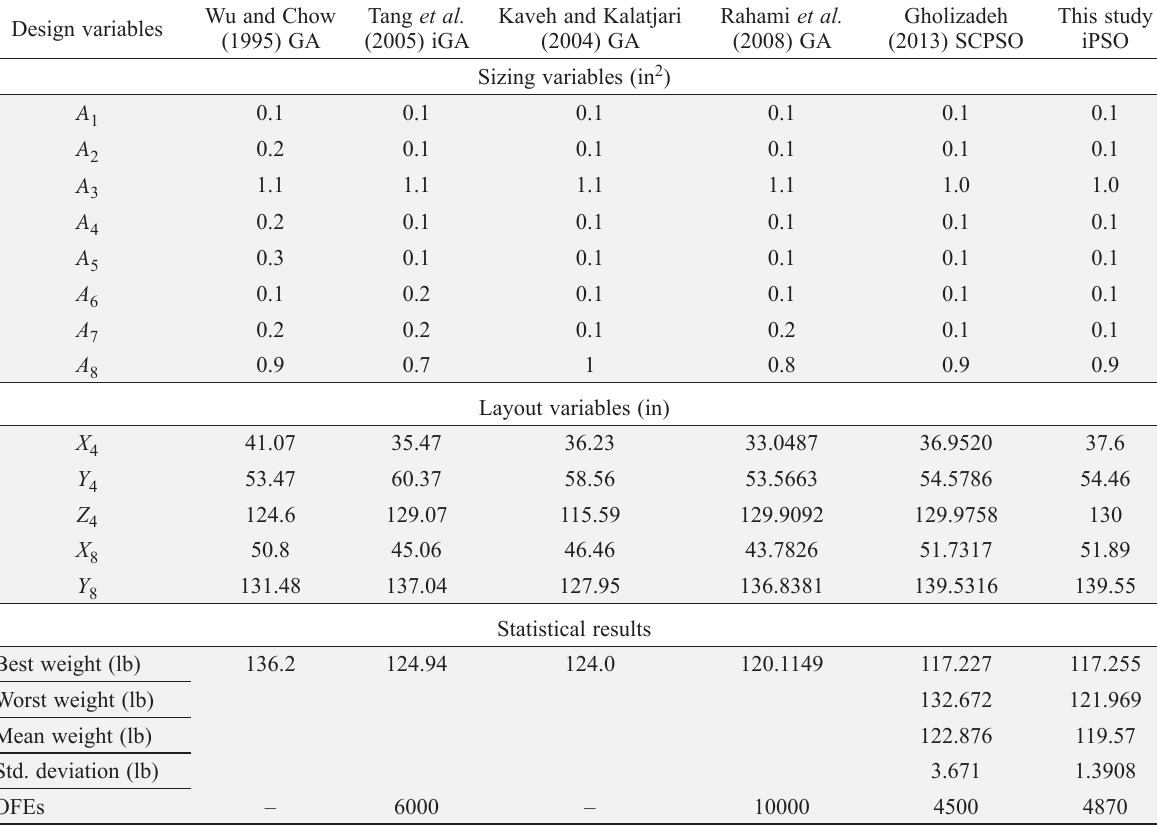
Table 7. Comparison of the iPSO optimization results with the literature for the spatial 25-bar truss problem Design